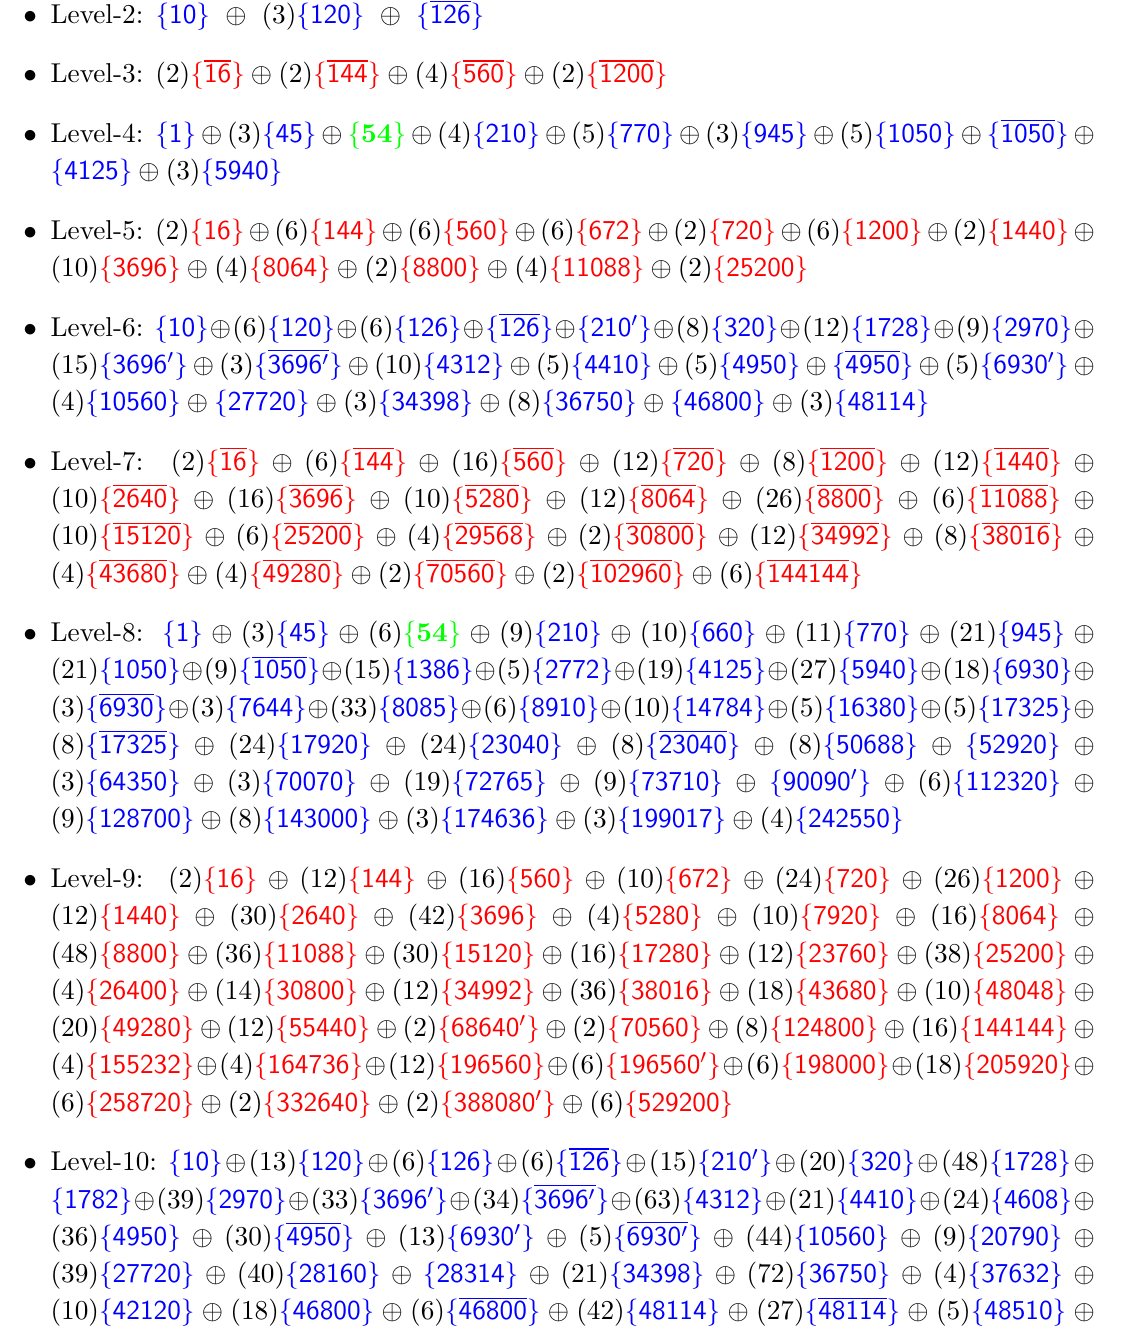
(6) f 258720 g (cid:8) (2) f 332640 g (cid:8) (2) f 388080 0 g (cid:8) (6) f 529200 g (cid:15) Level-10: f 10 g(cid:8) (13) f 120 g(cid:8) (6) f 126 g(cid:8) (6) f 126 g(cid:8) (15) f 210 0 g(cid:8) (20) f 320 g(cid:8) (48) f 1728 g(cid:8) f 1782 g(cid:8) (39) f 2970 g(cid:8) (33) f 3696 0 g(cid:8) (34) f 3696 0 g(cid:8) (63) f 4312 g(cid:8) (21) f 4410 g(cid:8) (24) f 4608 g(cid:8) (36) f 4950 g (cid:8) (30) f 4950 g (cid:8) (13) f 6930 0 g (cid:8) (5) f 6930 0 g (cid:8) (44) f 10560 g (cid:8) (9) f 20790 g (cid:8) (39) f 27720 g (cid:8) (40) f 28160 g (cid:8) f 28314 g (cid:8) (21) f 34398 g (cid:8) (72) f 36750 g (cid:8) (4) f 37632 g (cid:8) (10) f 42120 g (cid:8) (18) f 46800 g (cid:8) (6) f 46800 g (cid:8) (42) f 48114 g (cid:8) (27) f 48114 g (cid:8) (5) f 48510 g (cid:8) (5) f 50050 g (cid:8) f 50050 g (cid:8) (16) f 64680 g (cid:8) (29) f 68640 g (cid:8) (10) f 70070 0 g (cid:8) (27) f 90090 g (cid:8) (15) f 90090 g(cid:8) (3) f 102960 0 g(cid:8) (6) f 144144 0 g(cid:8) (11) f 150150 g(cid:8) (24) f 192192 g(cid:8) (9) f 216216 g(cid:8) f 258720 0 g (cid:8) (24) f 299520 g (cid:8) f 351000 g (cid:8) (4) f 369600 g (cid:8) (3) f 371250 g (cid:8) (8) f 376320 g (cid:8) (12) f 380160 g (cid:8) (8) f 436590 g (cid:8) (3) f 590490 g (cid:8) (3) f 630630 g (cid:8) (12) f 705600 g (cid:8) f 831600 g